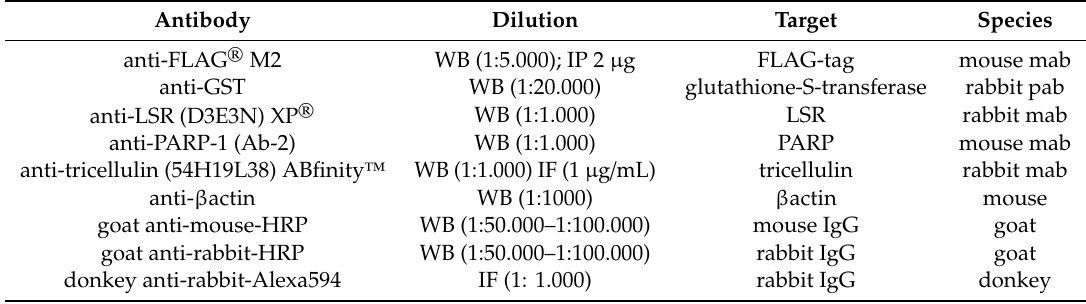
Antibodies used in the presented study including dilutions for Western blotting, immunofluorescence microscopy and immunoprecipitation. Antibody Dilution Target